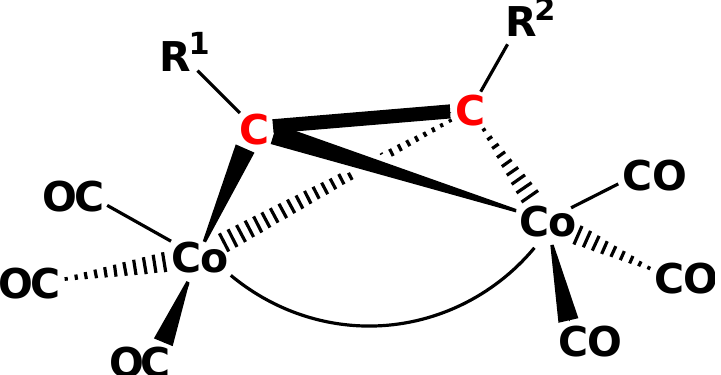
Figure 12. Schematic view of the structure of complexes 18 (R 1 , R 2 = H or organic group(s)) [65–67].